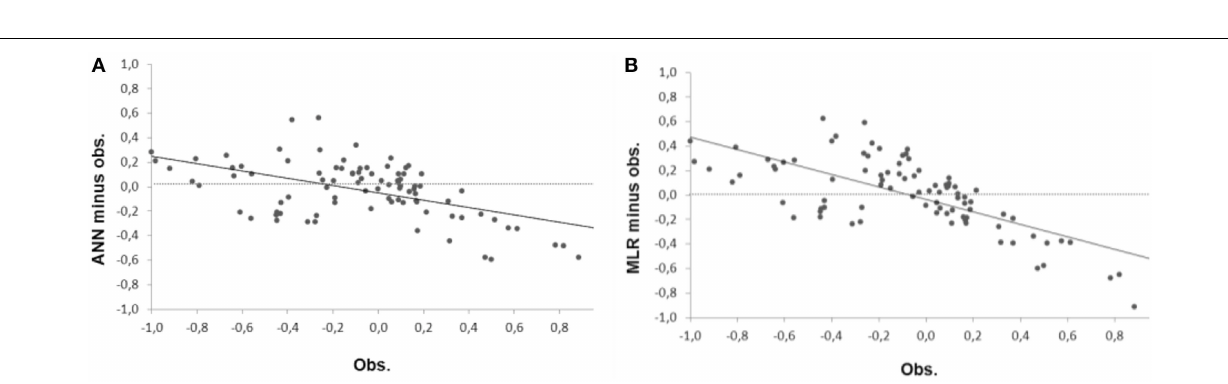
FIGURE 10 | Bias comparison between the simulated daily precipitation by the ANN (A) and MLR (B) models during FMA season of the 1963–2003 over the north of the